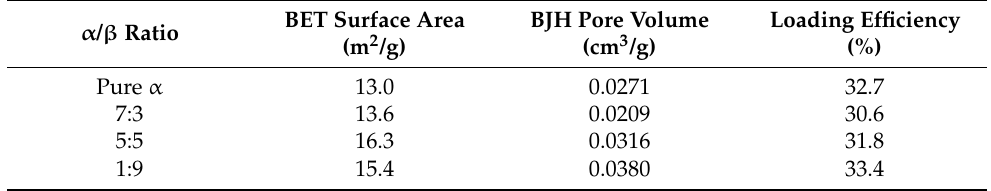
Table 1. Pore features and loading efficiencies of the pollen-like anhydrous lactose with tailored α / β